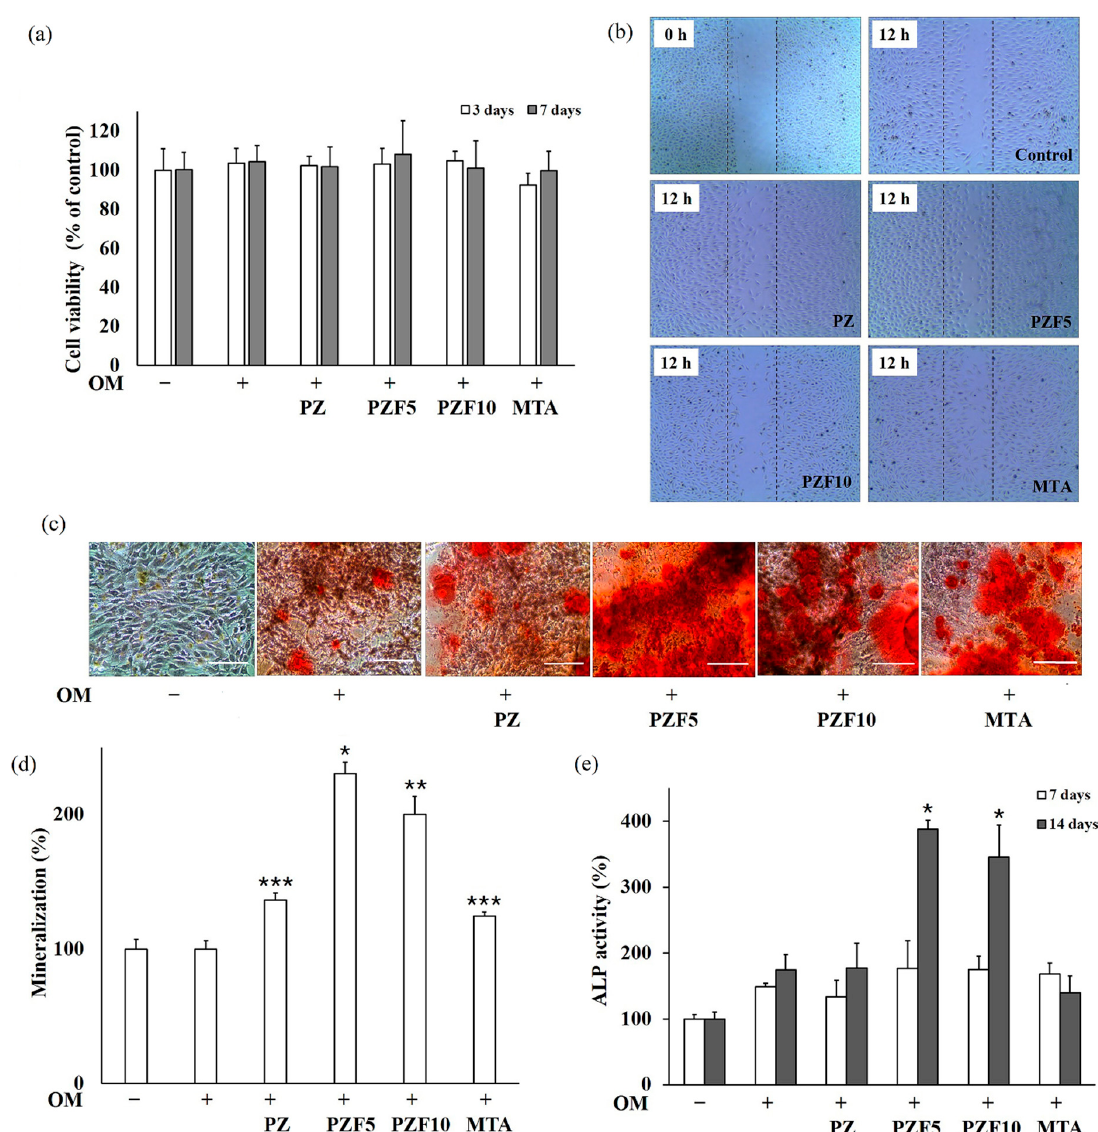
Figure 4. Biological effects of PZ, PZF5, PZF10 and MTA on cell viability, adhesion, and migration of MG63 human osteoblast-like cells. ( a ) Cell viability was determined by MTT assay after 3 and 7 days. ( b ) Cell migration was visualized by microscopy ( × 100) after 12 h. Alizarin Red S staining (ARS) was ( c ) visualized and ( d ) quantified at 612 nm. ( e ) The alkaline phosphatase (ALP) activity was analyzed by an ALP activity test and compared. Cells were cultured in osteogenic medium (OM) con- taining 50 µ g/mL L-ascorbic acid, 10 mM/mL β -glycerophosphate, and 10 –7 M/mL dexamethasone. * p < 0.05, ** p ≤ 0.01, *** p ≤ 0.001 compared to the group only conditioned by OM. The data are representative of three independent experiments. Scale Bar = 50 µ